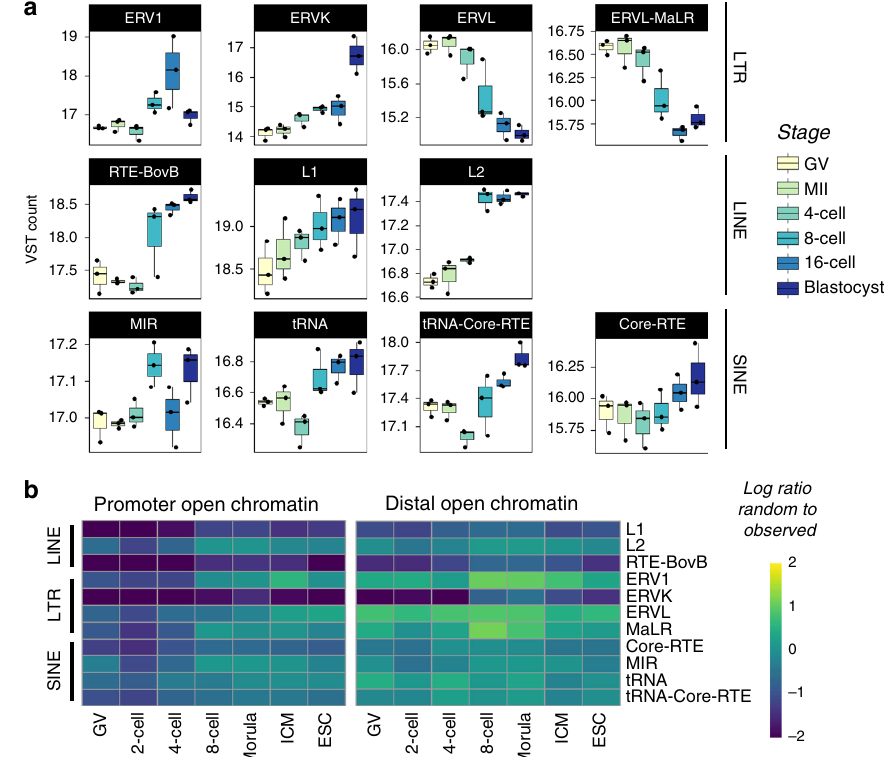
Fig. 6 Expression and accessibility dynamics of repeat families during bovine preimplantation development. Boxplots indicate the median and interquartile range (IQR), and whiskers span 1.5 times the IQR. a VST normalized expression pro fi les of select LTR, LINE, and SINE repeat families. RNA-seq data from Graf et al. 32 . b Enrichment of several transposable element (TE) families in ATAC-seq peaks, called from 30 million reads. Promoter peaks fell within the 2 kb region upstream of TSS. Intergenic peaks did not overlap the 2 kb regions upstream of TSS, exons, or introns ( n = 3 biologically independent samples). Source data are provided as a Source Data fi